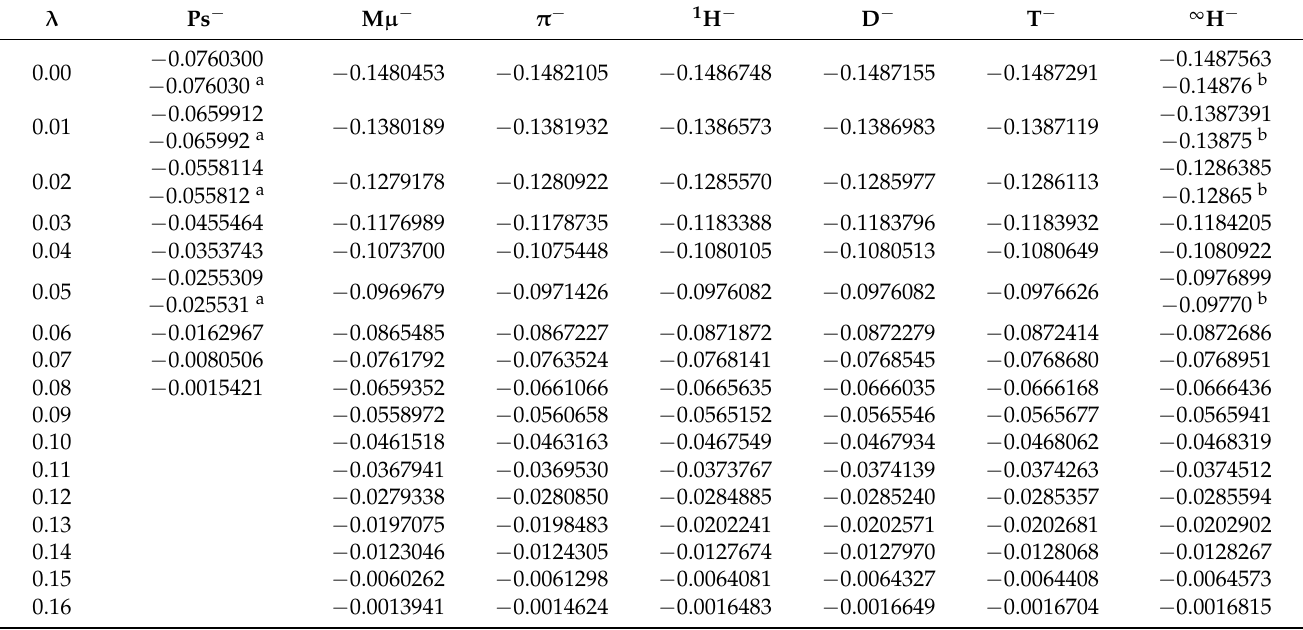
Table 1. 1 S e resonance energies E r (a.u.) of two-electron negative ions for different values of the screening parameter λ .